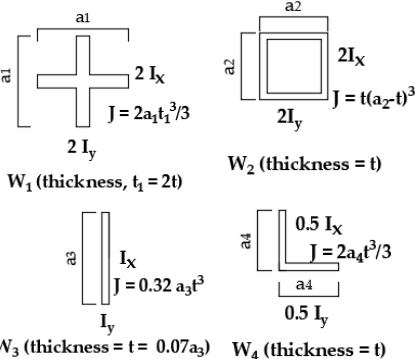
Figure 5. Structural details of the shear walls used in building models Figure 4a–j.